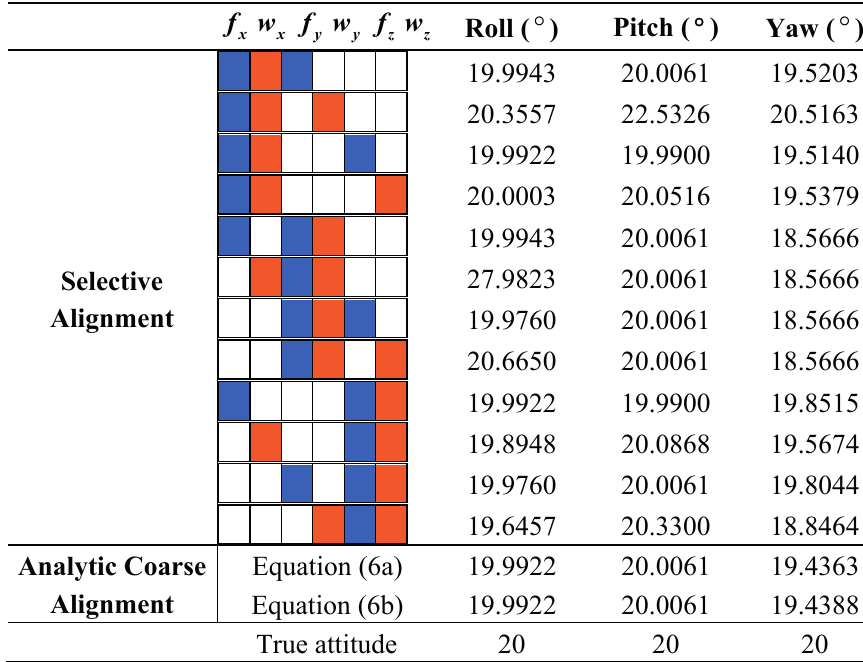
Table 5. The AA results for the self-calibration